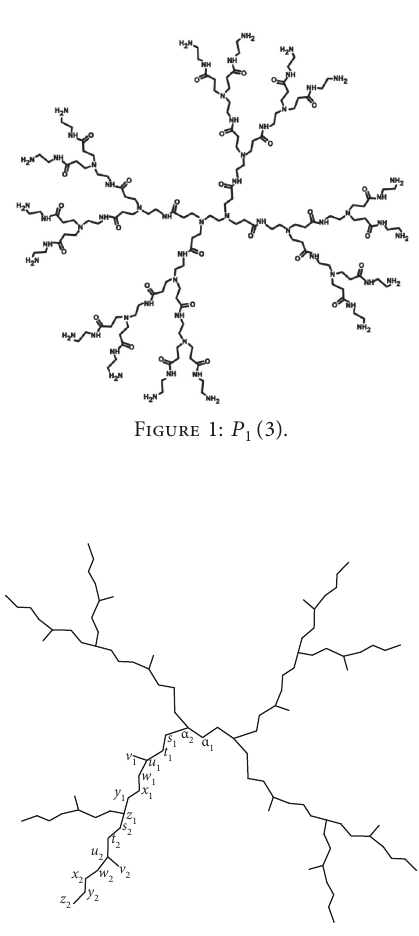
Figure 2: Labelled molecular graph P